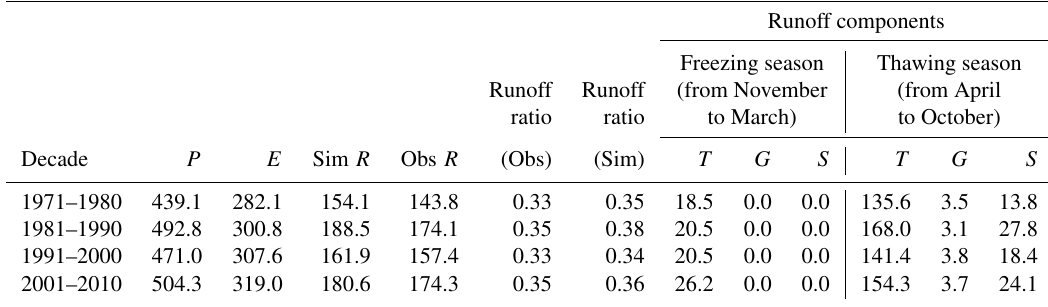
Table 2. Changes in annual basin water balance and runoff components (mmyear − 1 ) in different seasons.